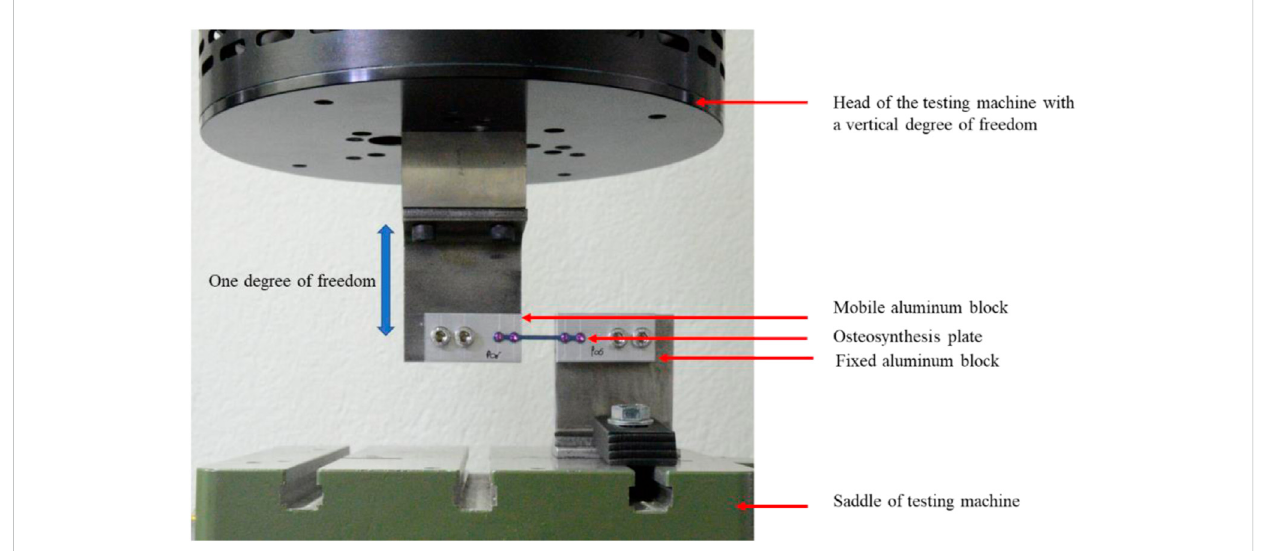
FIGURE 2 Cyclic bending experimental setup of the osteosynthesis plate. The plate was fi xed to two aluminum blocks with four self-tapping titanium miniscrews(2 mm).Onealuminumblockwas fi xedtothesaddleofthetestingmachine,whiletheotheronewasattachedtotheheadofthemachineand had a vertical degree of